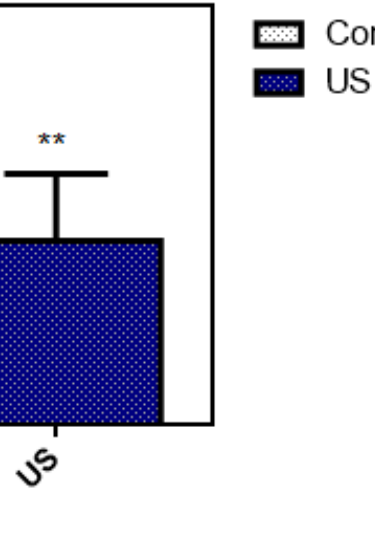
Figure 4. Oxidation of terephthalic acid (TA) to 2-hydroxyterephthalic acid (HTA) in the presence of hydroxyl radicals induced by inertial cavitation (one-way ANOVA, mean ± SD, n = 6, **: p < 0.01). The biocompatibility test of C-doped TiO 2 on cell viability by the WST-1 test is shown in Figure 5. After treatment with C-doped TiO 2 , the cell viability was 0.25 ± 0.24% (positive control group), 99.54 ± 10% (negative control group), 100 ± 24% (control group) and 81.49 ± 20% (C-doped TiO 2 group), respectively. The cell viability of the control group was 100% as the baseline. Each experiment was repeated 5 times. The biocompatibility test followed by the regulations of ISO 10,993 indicated that there would be no potential toxicity when the cell viability of the experiment group was over 75%. Based on the WST-1 test, C-doped TiO 2 showed no potential toxicity to normal cells.